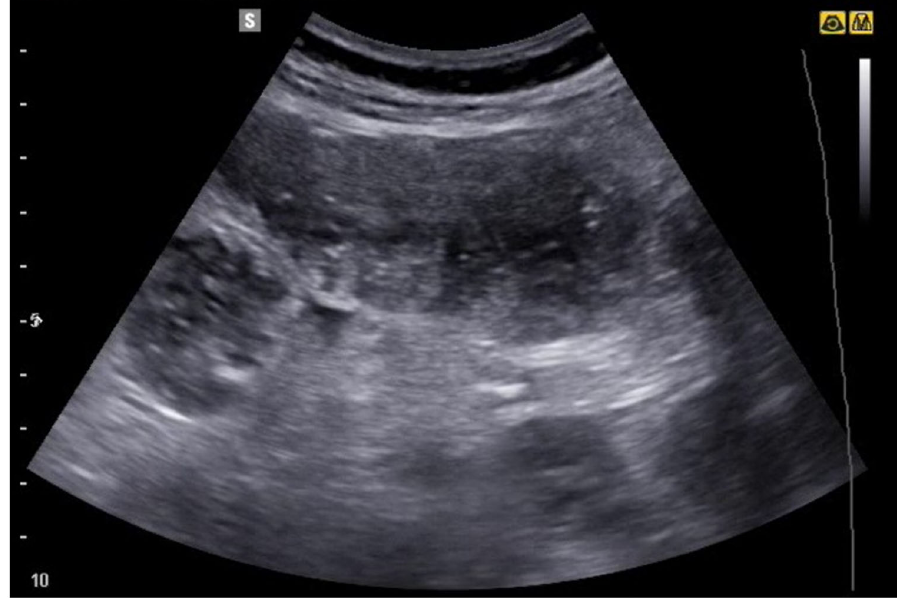
Figure 12. Image obtained with convex probe. Dilated loops of small intestine, with fecal material inside and thinned walls. Diagnosis of small bowel obstruction due to adhesions.